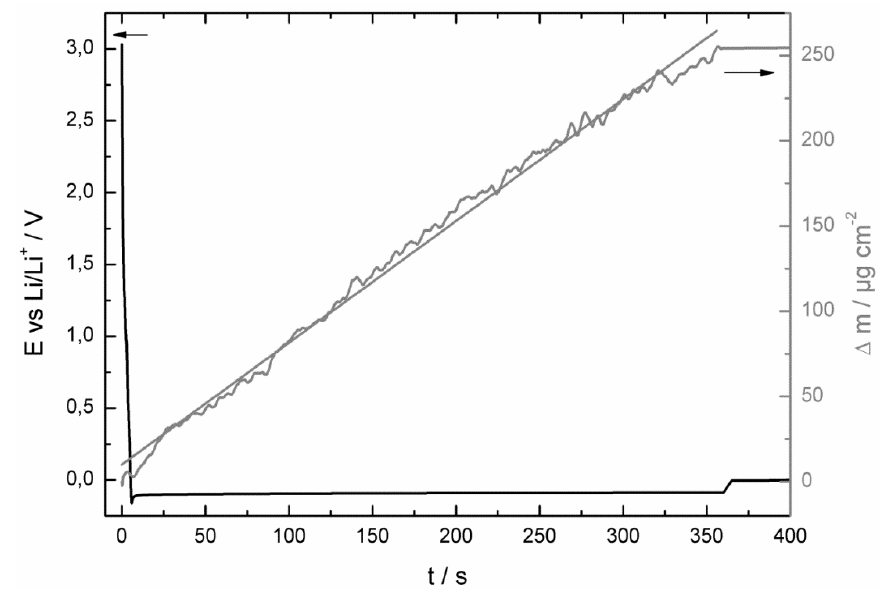
Figure 4. Time dependence of potential and attributed mass change during the chronopotentiometric deposition of lithium on the copper foil on quartz in 1 M LiPF EC:DEC (3:7, by